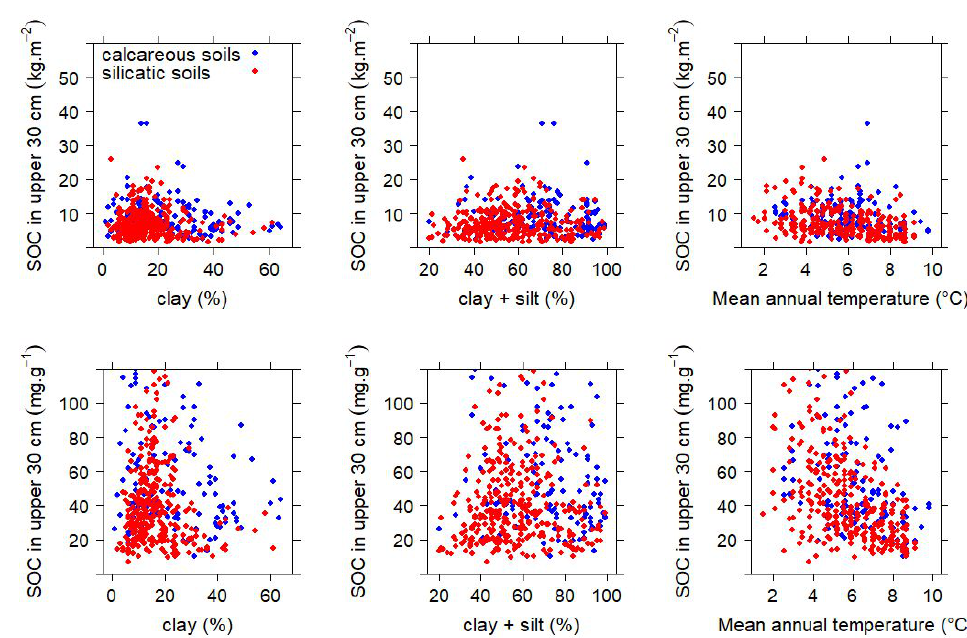
Figure 4. Relation of soil organic carbon stock, and concentration, respectively, soil texture and air temperature in Austrian forest soils. Upper panel: Relation of organic carbon stocks with the clay content ( left ), the sum of clay and silt ( center ), and air temperature ( right ). Lower panel: Relation of organic carbon concentrations with the clay content ( left ), the sum of clay and silt ( center ), and air temperature ( right ). Air temperature represents the mean of the years 1960–1990. The different color represent the bedrock material (blue: soils derived from calcareous bedrock; red: soils derived from silicatic